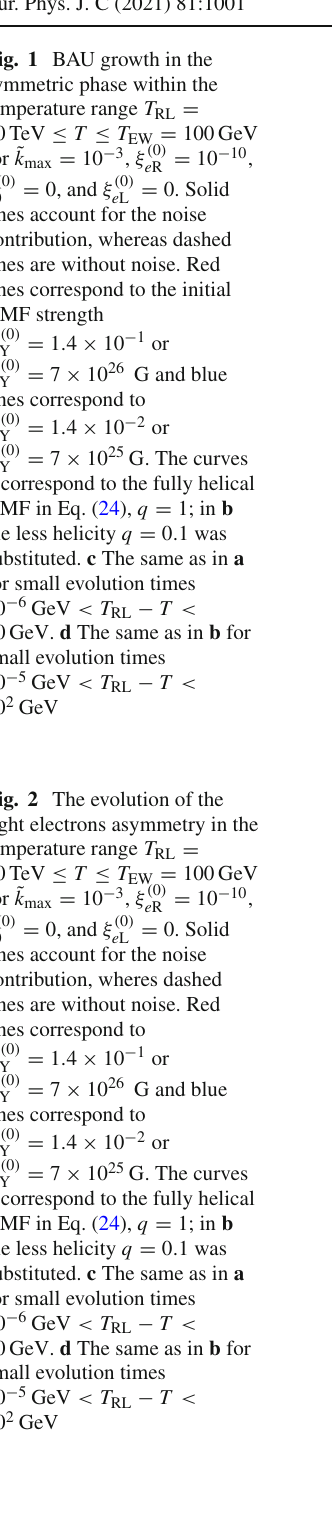
Fig. 2 The evolution of the right electrons asymmetry in the temperature range T RL = 10TeV ≤ T ≤ T EW = 100GeV ( 0 ) = 10 − 10 , for ˜ k max = 10 − 3 , ξ e R ξ ( 0 ) = 0, and ξ ( 0 ) = 0. Solid e L 0 lines account for the noise contribution, wheres dashed lines are without noise. Red lines correspond to ˜ B ( 0 ) = 1 . 4 × 10 − 1 or Y = 7 × 10 26 G and blue B ( 0 ) Y lines correspond to ˜ B ( 0 ) = 1 . 4 × 10 − 2 or Y = 7 × 10 25 G. The curves B ( 0 ) Y a correspond to the fully helical HMF in Eq. (24), q = 1; in b the less helicity q = 0 . 1 was substituted. c The same as in a for small evolution times 10 − 6 GeV < T RL − T < 10GeV. d The same as in b for small evolution